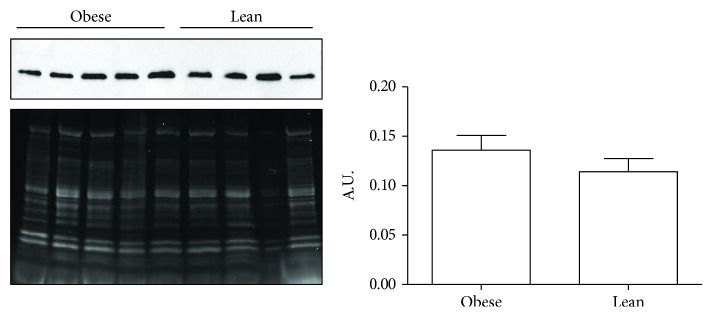
Western blot analysis of RAGE expression in obese and lean hearts. RAGE protein levels were quantified in 5 obese and 4 lean heart samples by Western blot analysis. The fifty μg protein extract/lane was analyzed with the anti-RAGE antibody. A representative blot, the corresponding stain-free gel utilized for protein normalization, and the semiquantitative analysis are shown. Data are expressed as mean ± SD.